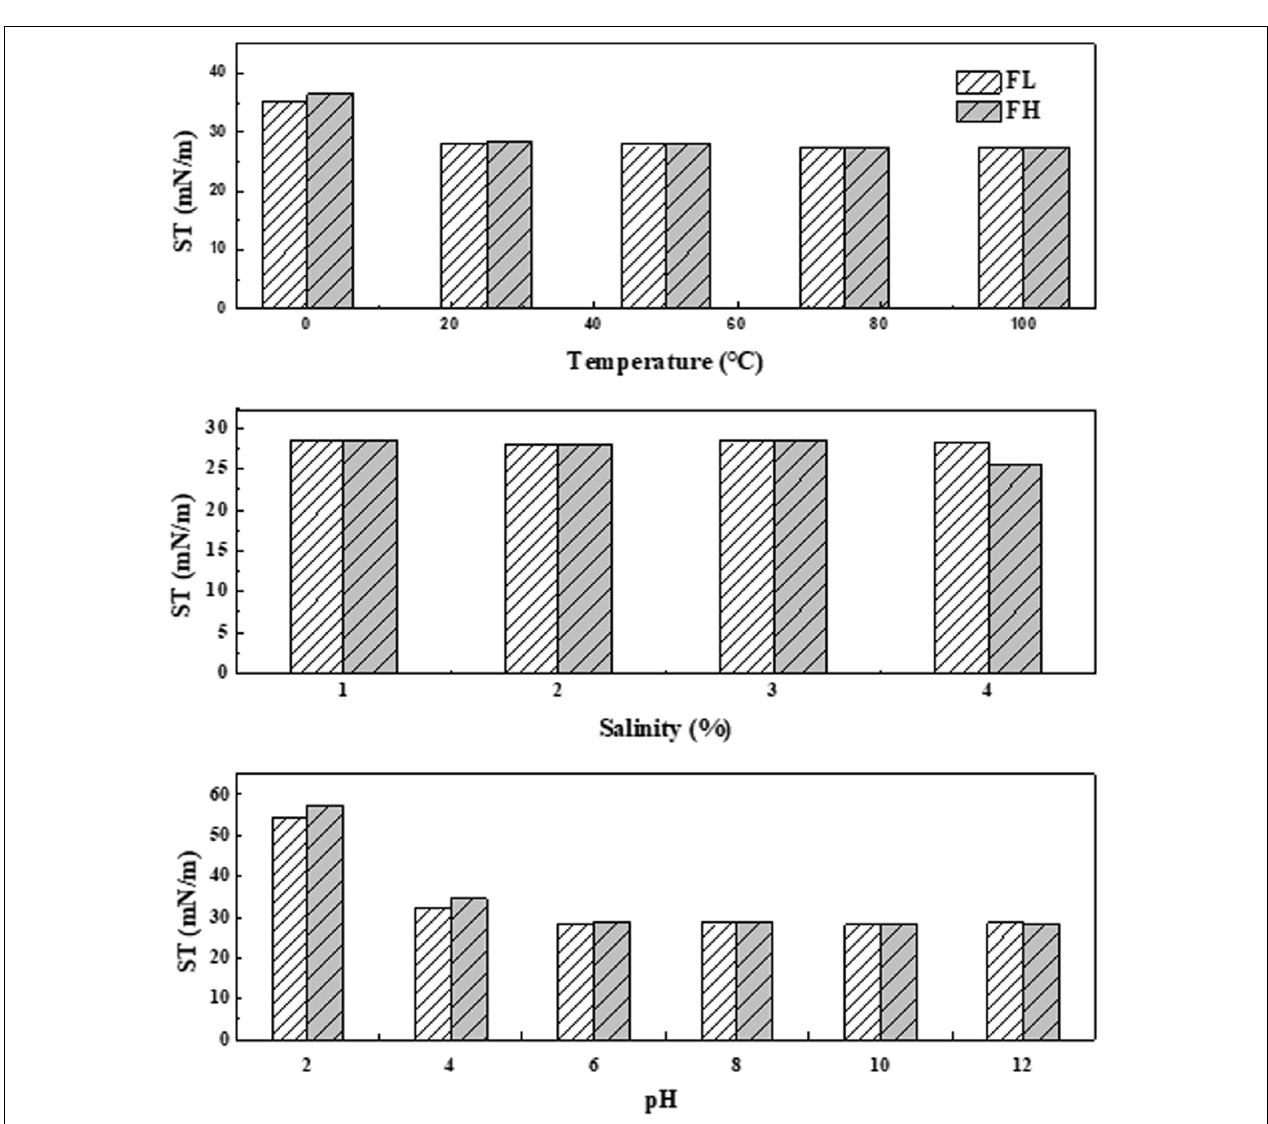
FIGURE 5 | Stability of biosurfactants generated by Bacillus subtilis N3-1P using fish liver (FL) or fish head (FH) as a comprehensive production medium at various temperatures, salinity and pH conditions in terms of surface tension